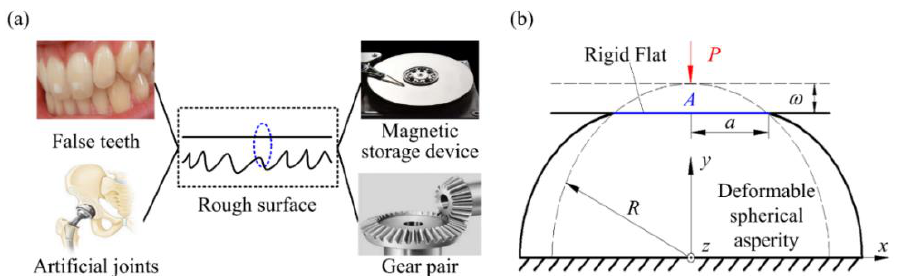
Figure 1. ( a ) Various examples of surface fatigue wear, and ( b ) the spherical contact model for one single